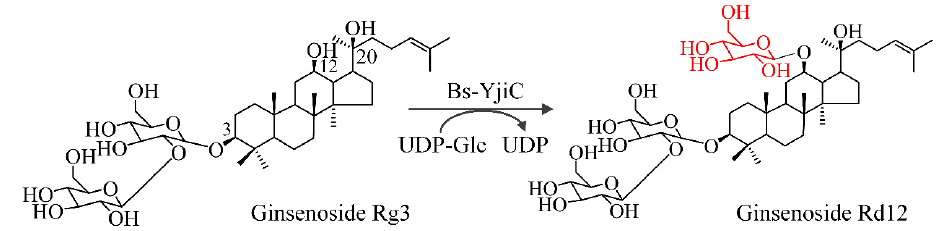
Figure 1. Chemical structures of ginsenosides Rg3 and Rd12.